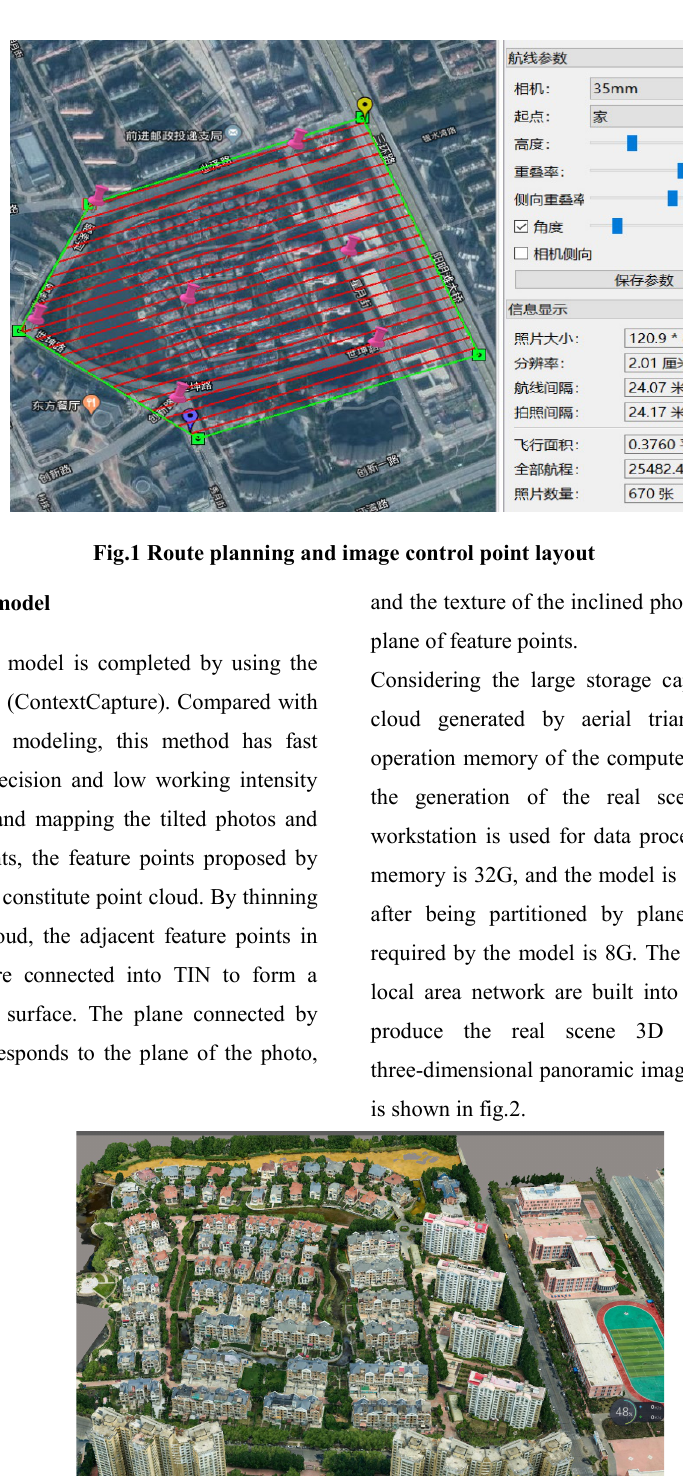
Fig.2 Real 3D panorama of the